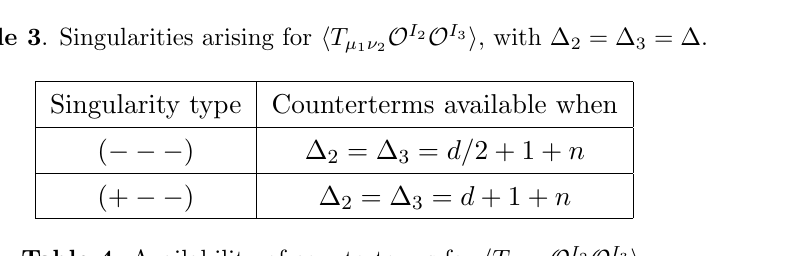
O I 2 O I 3 i 1 (cid:23) 1